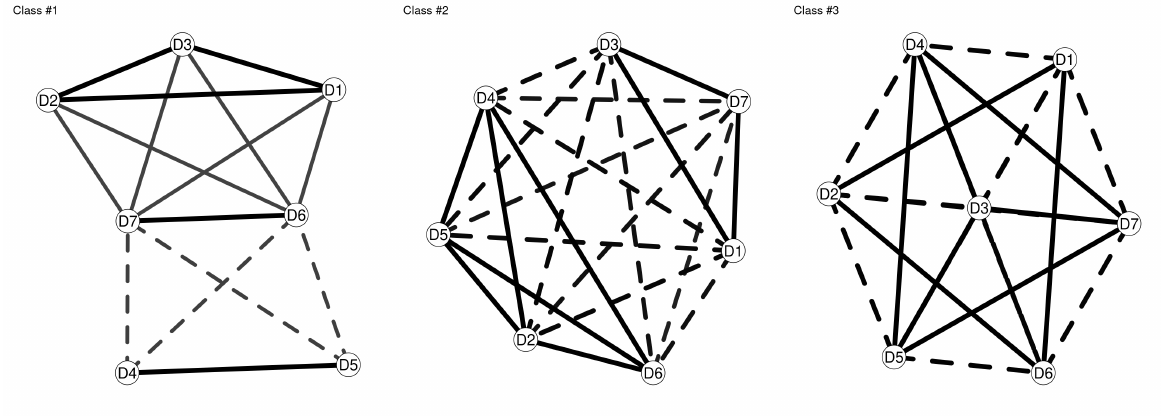
Figure 5: Graphs of three simulated schematic patterns. Note : The correlation networks plot all statistically significant Pearson correlation coefficients ( α = 0.5, two-tailed). Correlations where | r | ij = 0.15 are not visualized. Positive correlations are shown with straight edges; negative correlations are shown as dashed edges. Darker and thicker edges represent stronger bivariate correlations. The network is spatially arranged using the Fruchterman-Reingold force-directed algorithm so that directions with stronger correlations are placed closer together and those with weaker correlations are “repulsed” from one another (with a repulsion factor equal to 1.86). All classes consist of 40